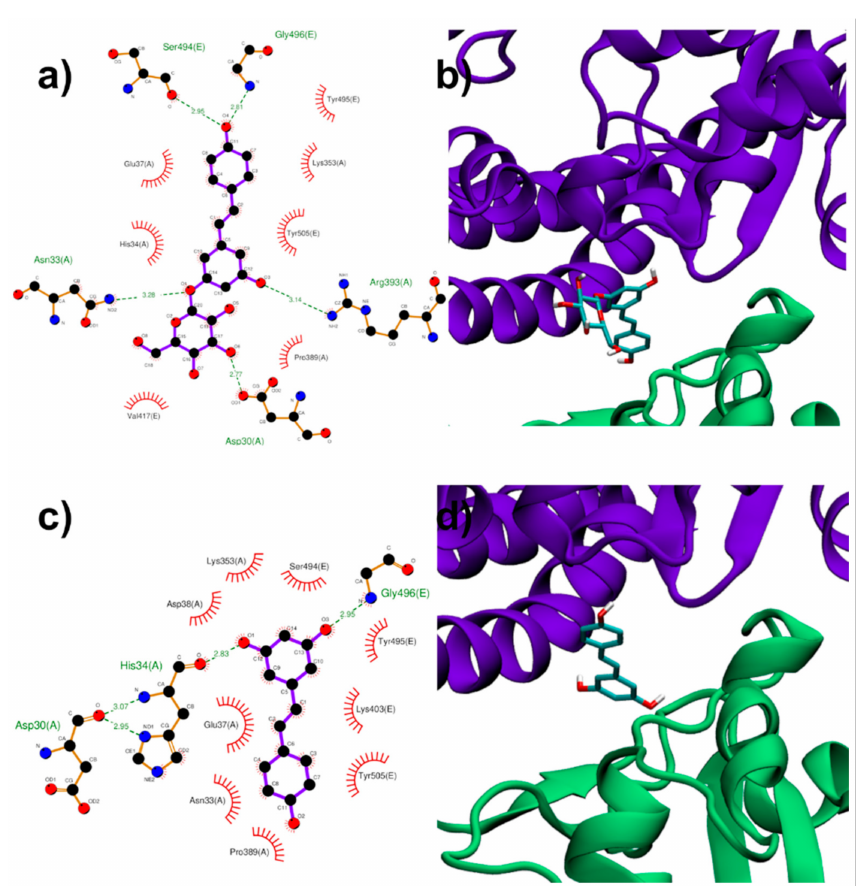
Figure 4. PD ( a , b ) and RESV ( c , d ) top-ranked poses docked to Spike:ACE2 interface region